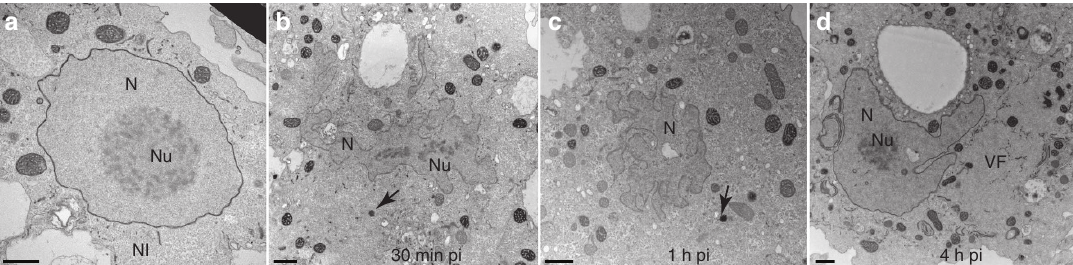
Figure 9 | Ultrathin-section TEM images of nuclei of A. castellanii cells undergoing a Noumeavirus infection. Noumeavirus infection of ( a ) non-infected cells, the nucleolus (Nu) in the nucleus (N) is electron-dense and compact. ( b ) In cells infected by Noumeavirus at 30min pi, the nucleus is drastically modified with many circumvolutions and the nucleolus appears disorganized and less electron-dense. Electron-dense nucleoids can be seen in the cytoplasm (black arrows and Fig. 8, white arrows) ( c ) 1h pi the nucleus is still deformed and nucleoids are still visible. ( d ) 4h pi the nucleus recovered its spherical shape with electron-dense and compact nucleolus and coexists with viral factories (VF). Scale bar, 1 m